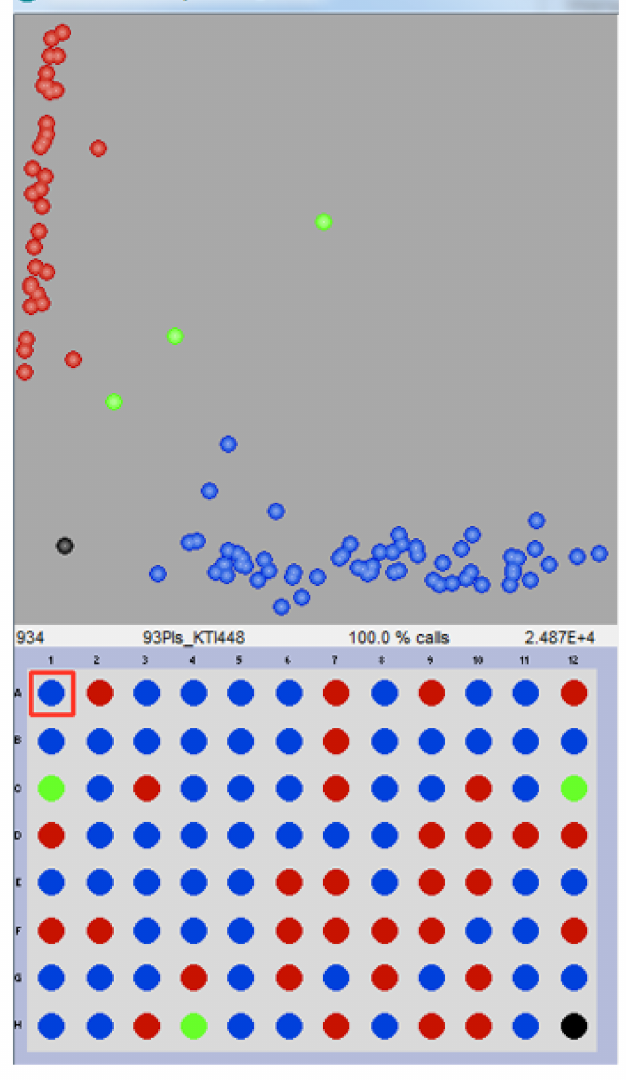
Figure 4. KlusterCaller TM genotyping results. Gm08_44814503 SNP genotyping results of the 93 PIs and Glenn (well 12F) and PI 547,656 (well 12G) are shown in the Cartesian cluster plot. Blue data points are homozygous lines for the low KTI allele reported by FAM dye, green data points are heterozygous lines and red data points are homozygous lines for the normal KTI allele reported as HEX dye. The black data point represents the no template control (NTC). The DNA sample 96-well plate layout is shown below the cluster